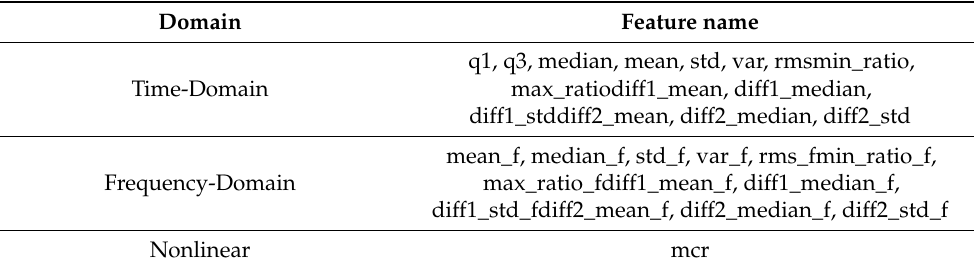
Table 1. 29 Features Extracted in This